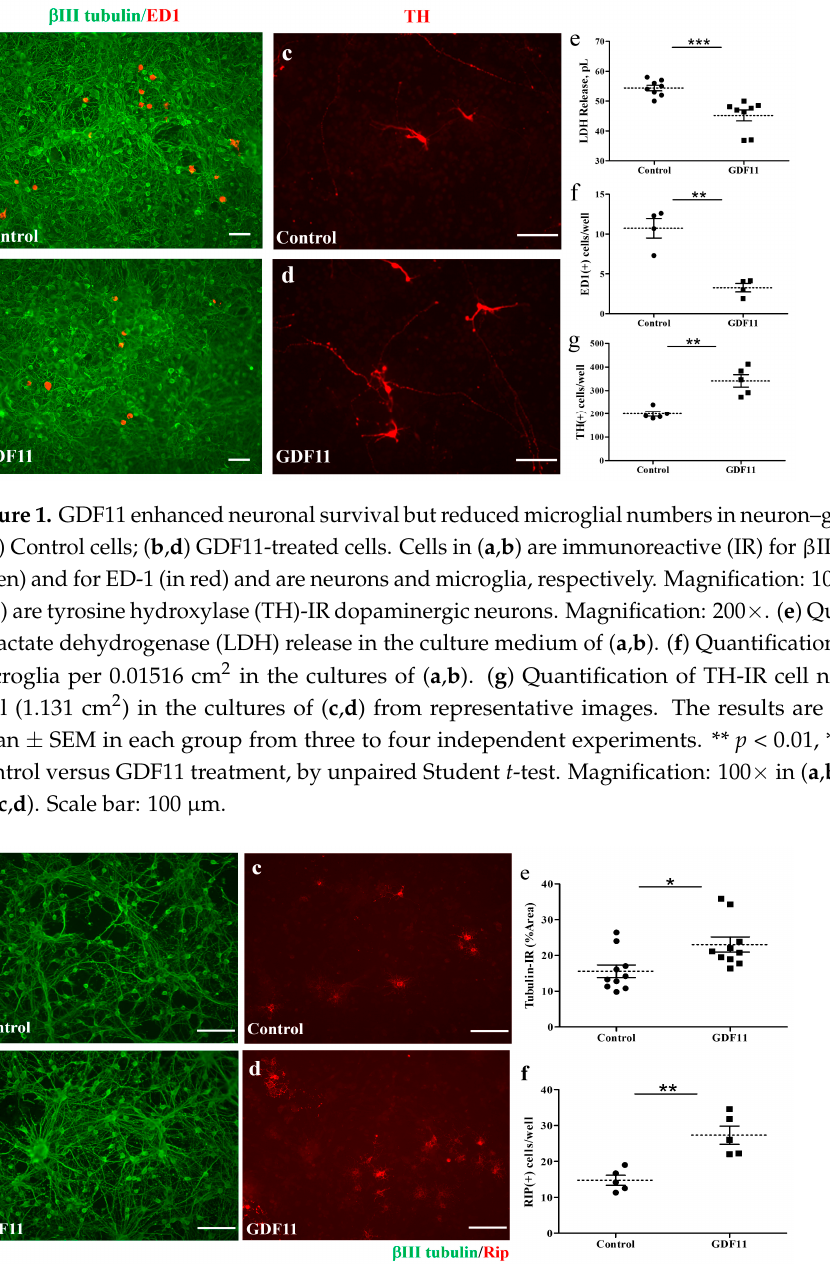
Figure 3. Effects of GDF11 on neurite extension and cell migration in spinal cord neuron–glial cul- tures. ( a , b ) Cells were seeded in ibidi inserts with a gap of approximately 594.2 ± 10.7 μ m. After